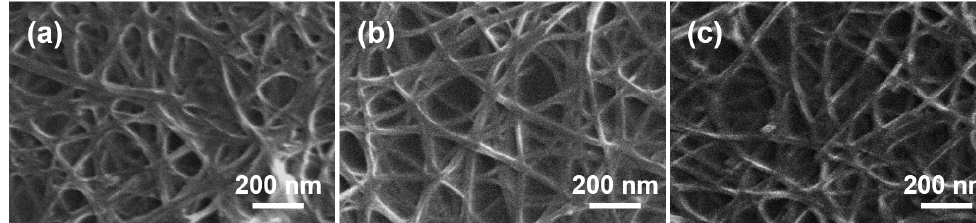
Figure 1. SEM images of the modified single-walled carbon nanotube (SWNT) bundles: ( a ) before cleaning; ( b ) thermal cleaning; and ( c ) plasma cleaning. Sensors 2017 , 17 , 73 Figure 2. Static contact angle data for the heat-cured SWNT (t-SWNT) and O 2 plasma-treated SWNT (p-SWNT) at various conditions. Note that the p-SWNT shows much smaller standard deviation of the observed contact angle than the t-SWNT does.